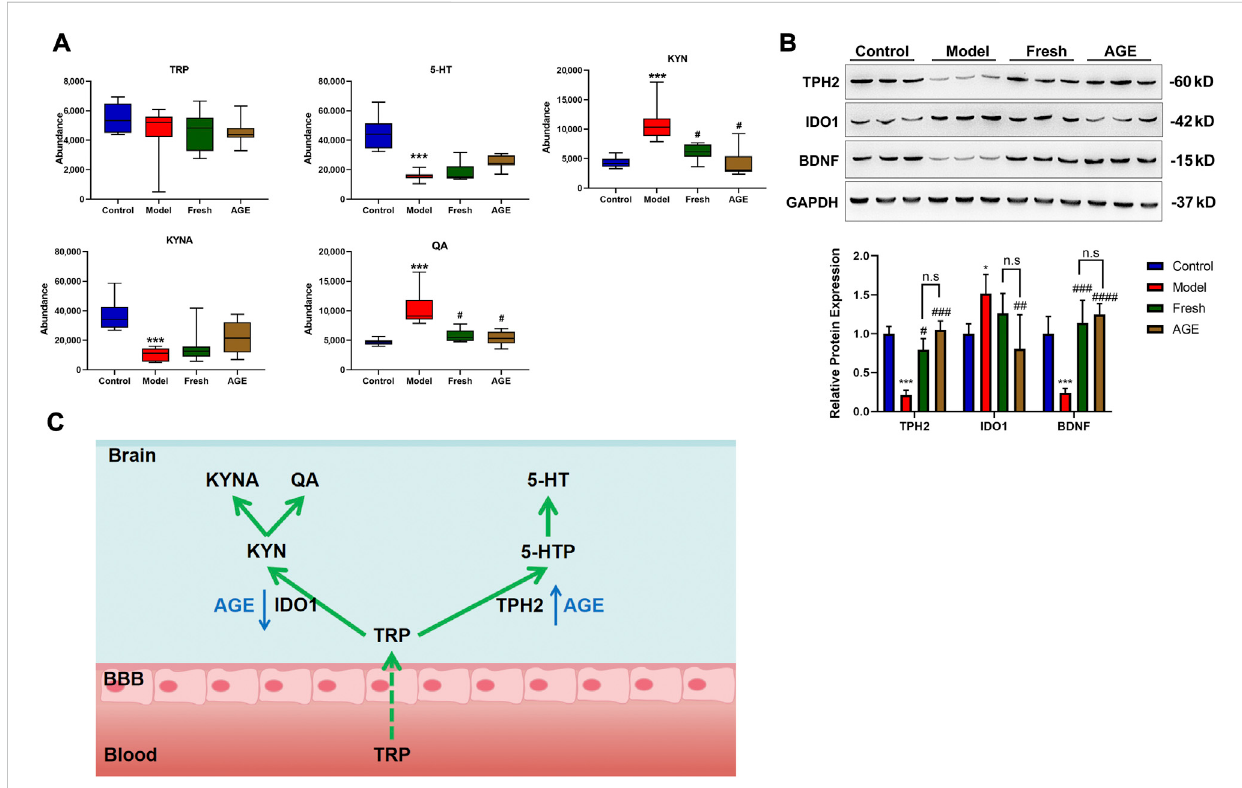
The effect of fresh GE and AGE interventionon thetryptophan metabolism inwhole brain samples. (A) Tryptophanrelated metabolites, (B) therate- limiting enzyme of tryptophan metabolic pathway. (C) Integration analysis of the AGE target pathways in anxiety mice. * p < 0.05; ** p < 0.01; *** p < 0.001 represent compared with the control group. # p < 0.05; ## p < 0.01; ### p < 0.001 represent compared with the model group. ns represents no signi fi cantdifferencebetweenfreshGEandAGEgroups. p < 0.05wasconsideredstatisticallysigni fi